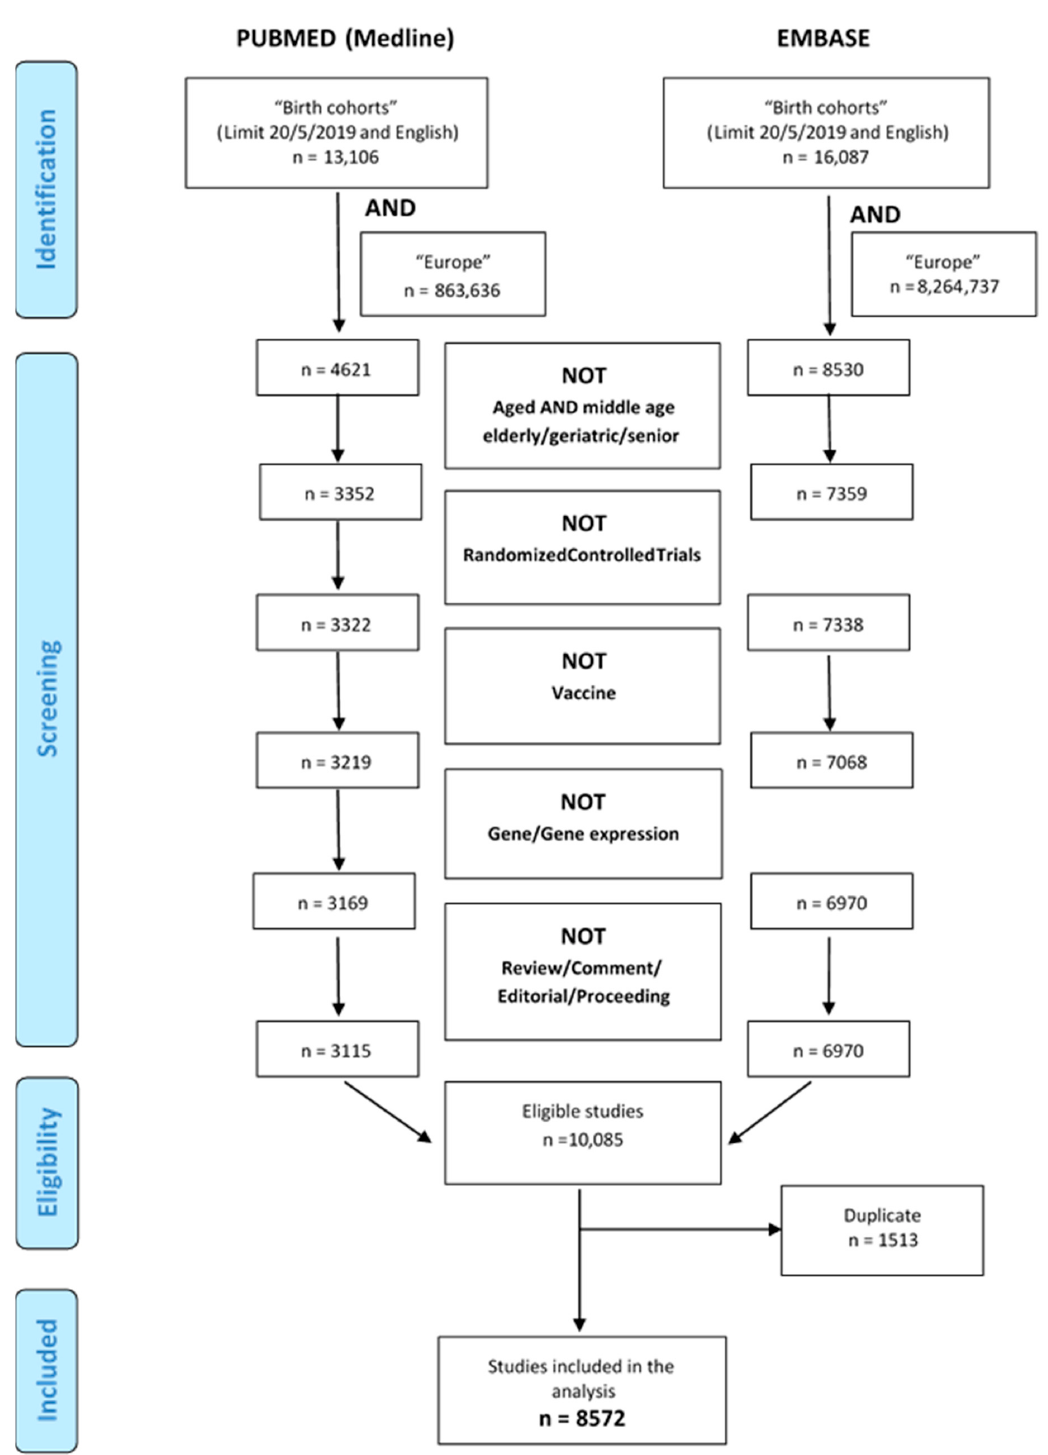
Figure 1. Literature selection from the two databases: Medline and Embase.